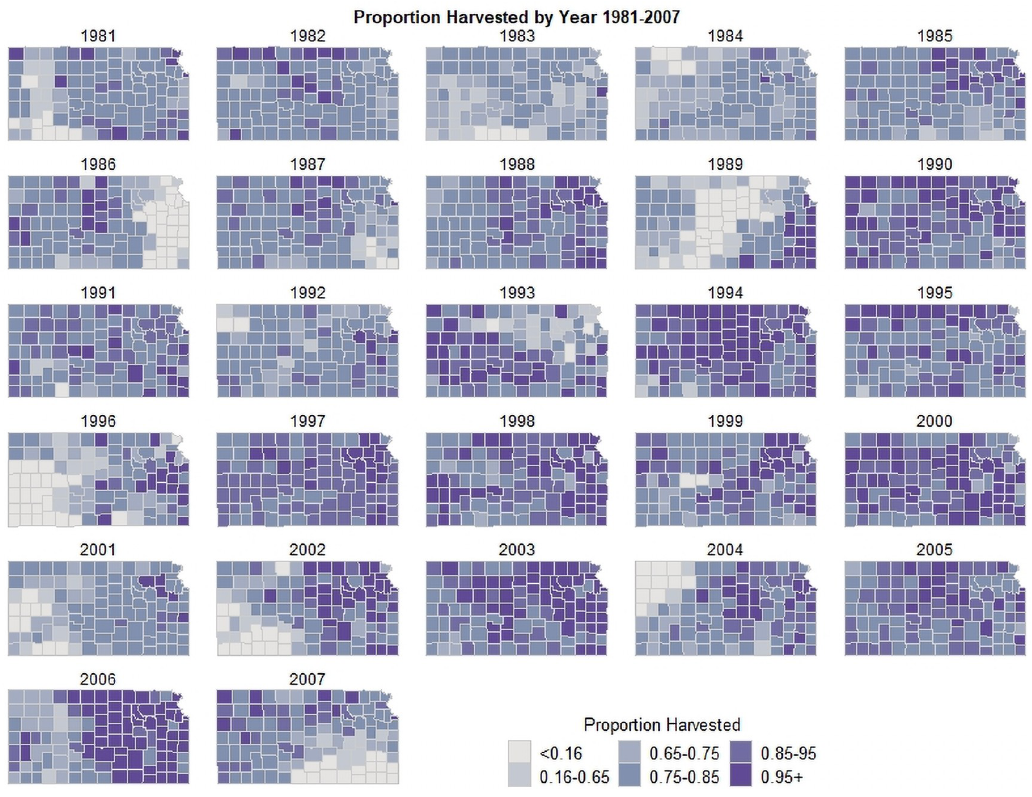
Fig 1. The distribution of proportion of winter wheat acres harvested in Kansas